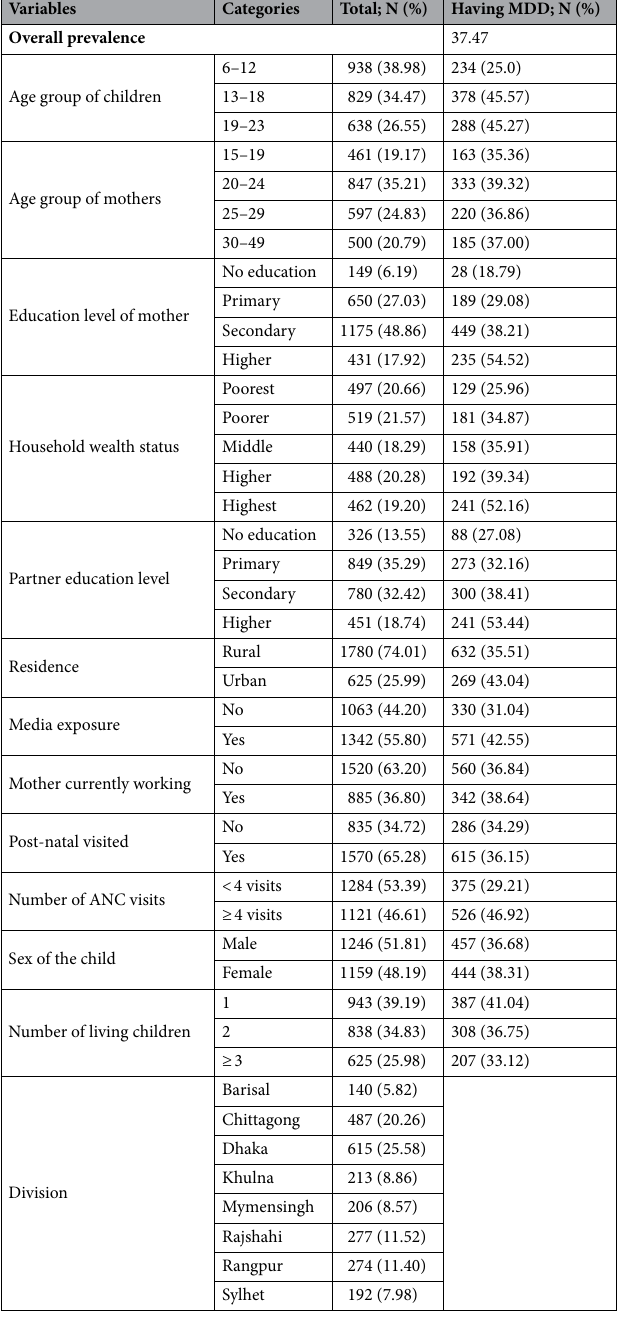
Table 1. Background characteristics of participants and distribution of minimum dietary diversity among the explanatory